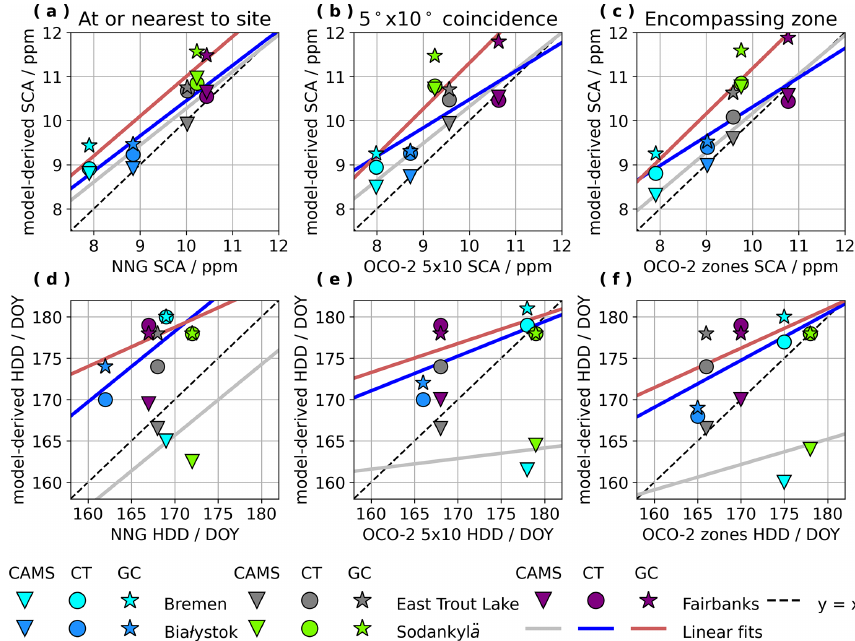
Figure 2. Correlations of observed versus model-derived SCA and HDD. Observed X CO seasonal cycles are based on NNG and OCO-2 2 satellite-based observations, while model-derived X CO seasonal cycles are based on estimates from the CAMS, CT2019B, and GC-CT2019 2 model frameworks. SCA and HDD are compared for three spatial types at each of the five ground sites: seasonal fits of near-noon ground- based (NNG) observations from TCCON and EM27/SUN measurements are compared to fits of daily model estimates at the nearest model grid point to the ground site; seasonal fits of daily average OCO-2 retrievals that fall within the 5 ◦ latitude by 10 ◦ longitude region of coincidence, centered on the location of each ground site, are compared to fits of daily model estimates averaged across the coincidence region; seasonal fits of OCO-2 daily averages for the 5 ◦ latitude by 20 ◦ longitude zone containing each ground site are compared to fits of daily model estimates averaged across those same zones (see map in Fig. 1 and site details in Table